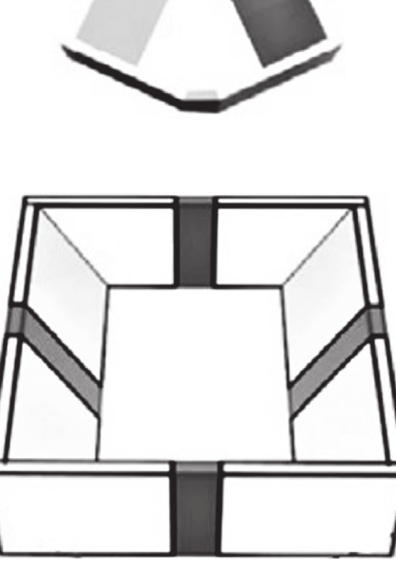
Figure 4: Bending configuration cell [22].